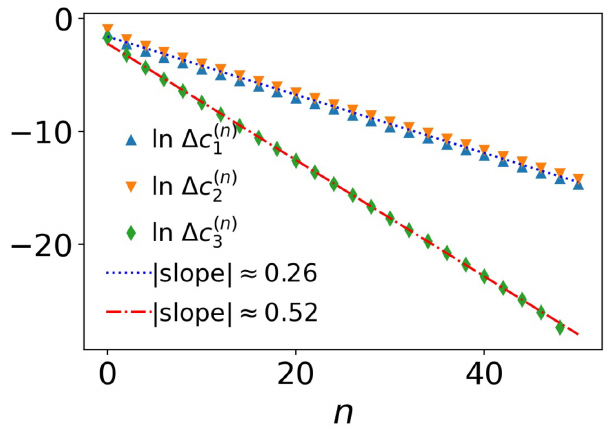
FIG. 6. Convergence for the initial condition inside the Weyl ) = (π/ 6, π/ 8, π/ 12 ) , c ( 0 ) , c ( 0 ) chamber: a seed unitary with ( c ( 0 ) 1 2 3 is evolved under the map for n = 50 steps. Both quantities (cid:17) c ( n ) = π/ 4 − c ( n ) = π/ 4 − c ( n ) and (cid:17) c ( n ) decay exponentially 1 1 2 2 ) | determined with approximately the same rate ξ = | ln sin ( 2 c ( ∞ ) 3 ≈ 0.443. The rate at which (cid:17) c ( n ) = c ( ∞ ) − c ( n ) → 0 is by c ( ∞ ) 3 3 3 3 or (cid:17) c ( n ) . The numerically calculated almost twice that of (cid:17) c ( n ) 1 2 slopes match with these values.